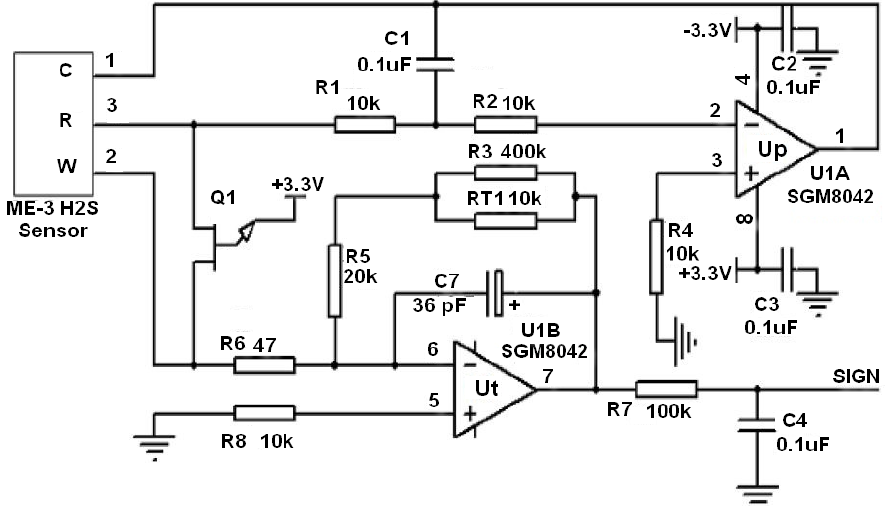
Figure 12. Circuit scheme of the conditioning section of the ME3-H2S sensor.